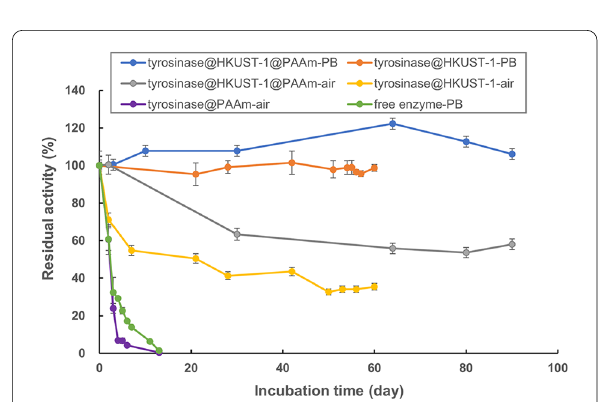
Fig. 3 Storage stability of tyrosinase@HKUST‑1 at 30 °C. In the labels, “PB” or “air” as the suffix refers to phosphate buffer (50 mM, pH 6.0) or air, respectively, in which the catalyst was incubated for